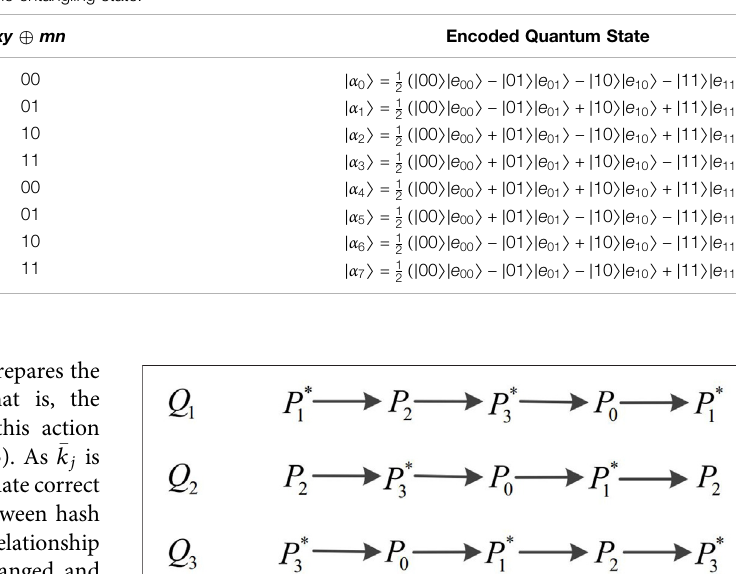
TABLE 3 | Quantum states after different encoding operations on the entangling state.